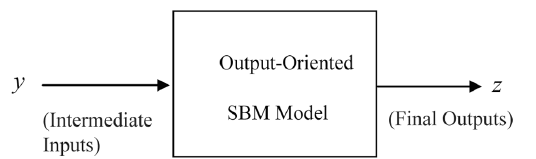
Fig. 3. Schematic diagram of the second-stage output oriented SBM